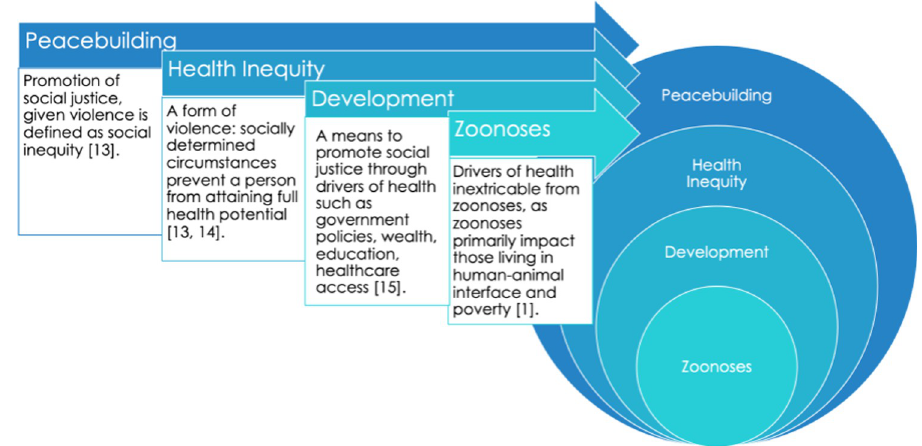
Fig 1. Situating zoonoses within peacebuilding and health theory